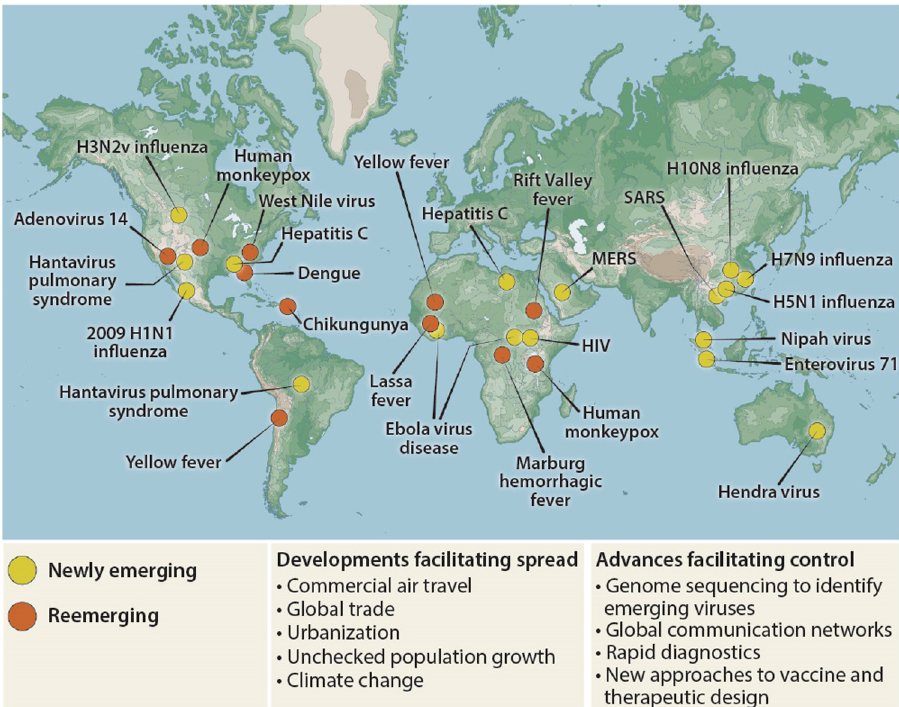
Fig 1. Mapping emerging viral diseases. Emerging diseases in new locations (orange) or caused by newly emerging viruses (yellow) are shown. Spread of emerging diseases are facilitated by urbanization and globalization, such as commercial air traffic and trade (with reprint permission taken from Marston and colleagues (https://www.science. org/doi/10.1126/scitranslmed.3009872); [6]).